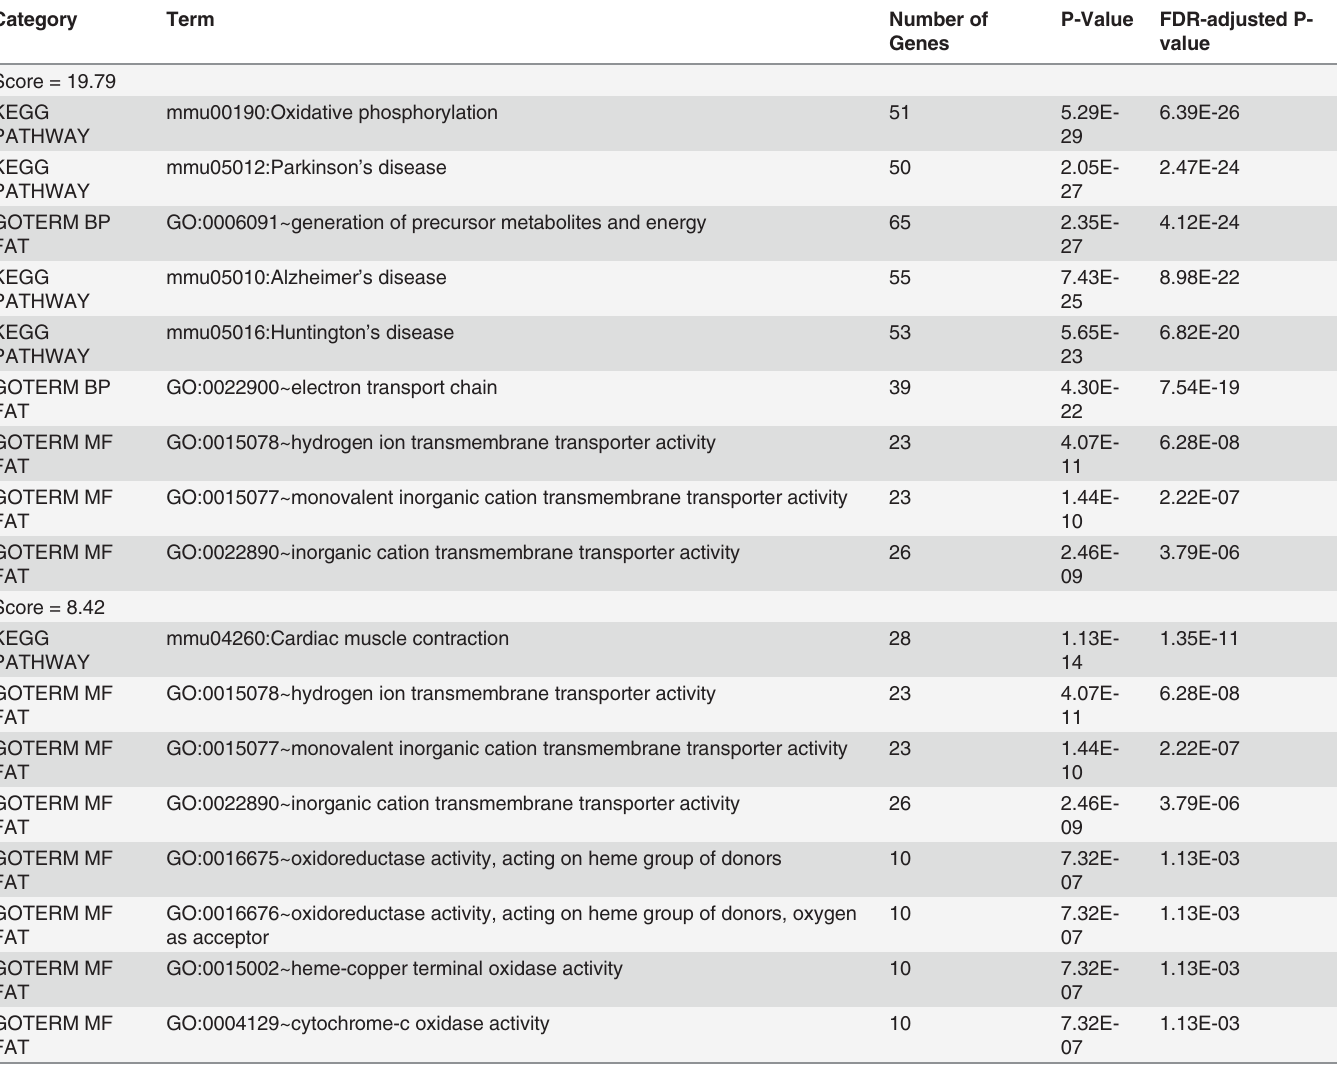
Table 10. Enriched (enrichment score > 8.0) clusters of Gene Ontology (GO) biological process (BP), molecular function (MF) Functional Annotation Tool (FAT) categories, and KEGG pathways among the genes differentially expressed between active and inactive mice (FDR- adjusted P-value <